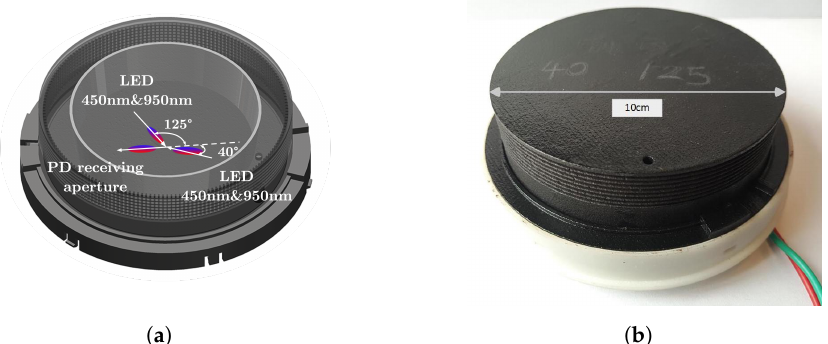
Figure 4. The design of the prototype sensor. ( a ) The 3D model of sensor. ( b ) The prototype sensor.